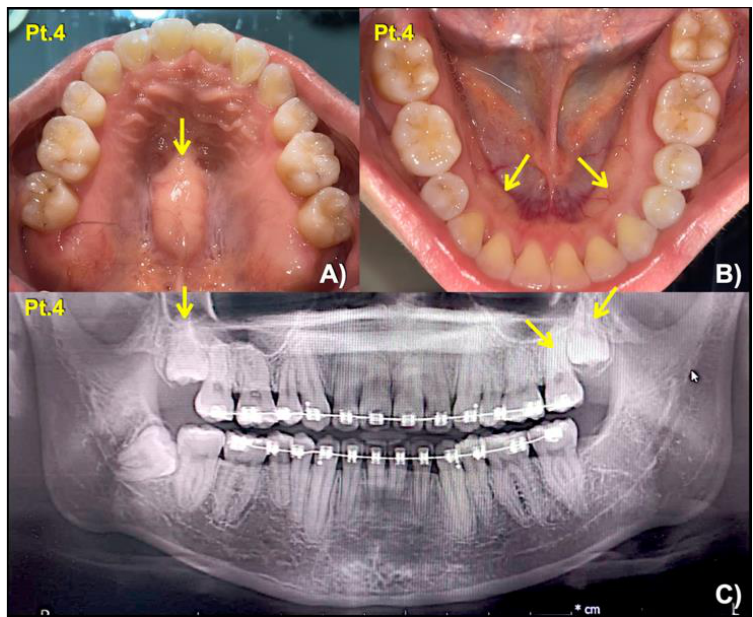
Figure 2. Mesiodens phenotypes. Extracted mesiodens of ( A ) patient 1, ( B ) patient 2. ( C ) patient 3. ( D , E ) Periapical radiographs show ( D ) Patient 5 — Inverted mesiodens (arrow). ( E ) Patient 6 — Unerupted mesiodens (arrow). ( F ) Patient 1 — Buccal exostoses (arrows). ( G ) Panoramic radiograph showing inverted mesiodens (arrow) and unseparated roots of the maxillary first permanent molars (asterisks).